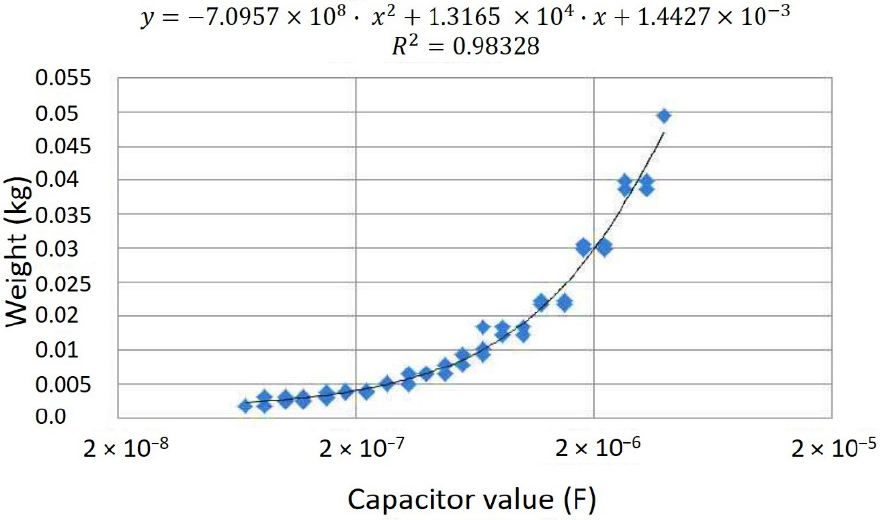
Figure 8. Example of datasheet interpolation.